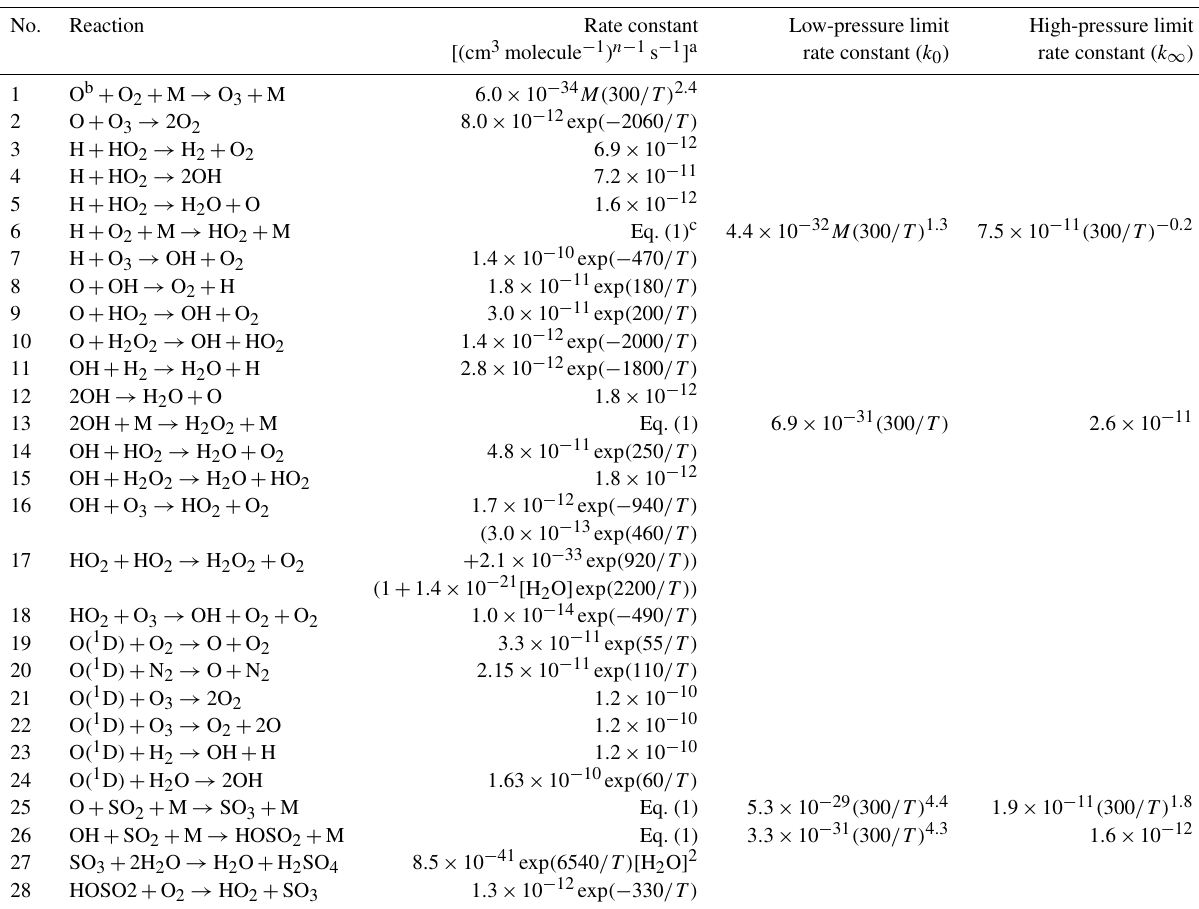
Table B2. Reactions in OH generation and SO 2